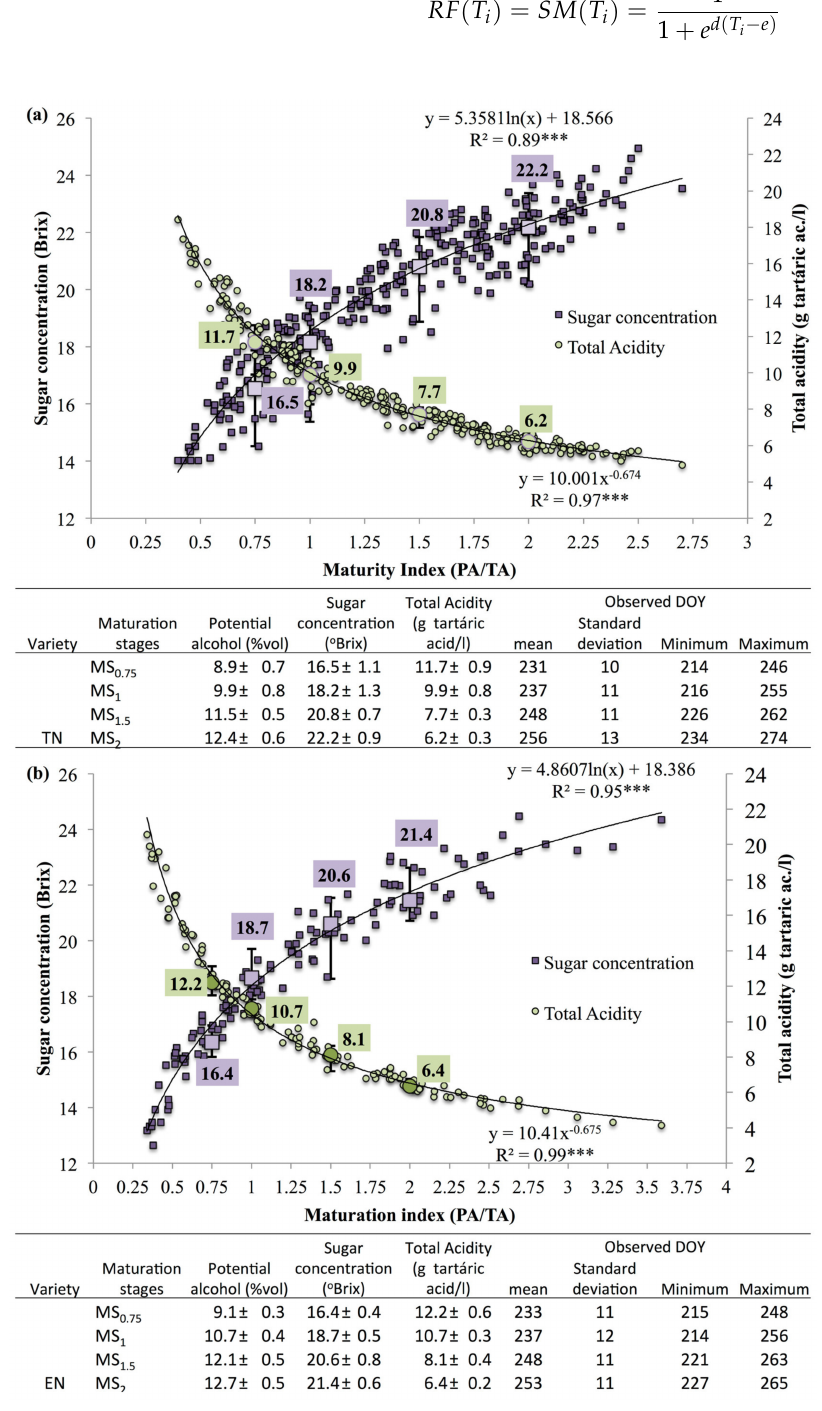
Figure 2. Relationship between the sugar concentration ( ◦ Brix) and total acidity (g of tartaric ac./l) of the grape must and maturation index (MI), calculated by the ratio of potential alcohol (%vol) and total acidity, for cv. ( a ) Touriga Nacional, TN, and ( b ) Encruzado, EN. Bottom tables: Mean and standard deviation of potential alcohol (PA), sugar concentration (SC), and total acidity (TA) for the four maturation stages (MS 0.75 , MS 1 , MS 1.5 and MS 2 ). The mean, standard deviation, and maximum/minimum of observed DOY for the four maturation stages are also listed. The mean values for SC and TA at the four maturation stages are also plotted in the graphs. *** p -value ≤